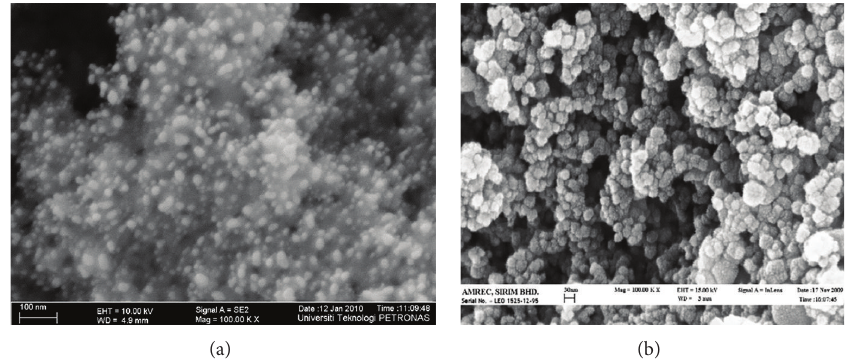
Figure 1: FESEM micrograph of (a) bare TiO 2 and (b) Cu-Ni/TiO 2 photocatalysts (at magnification 100KX) [17].